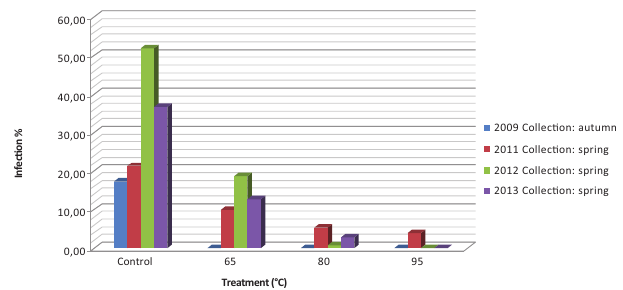
Figure 2 : Influence of hot water treatment on infection (%) of Sida h . Seeds